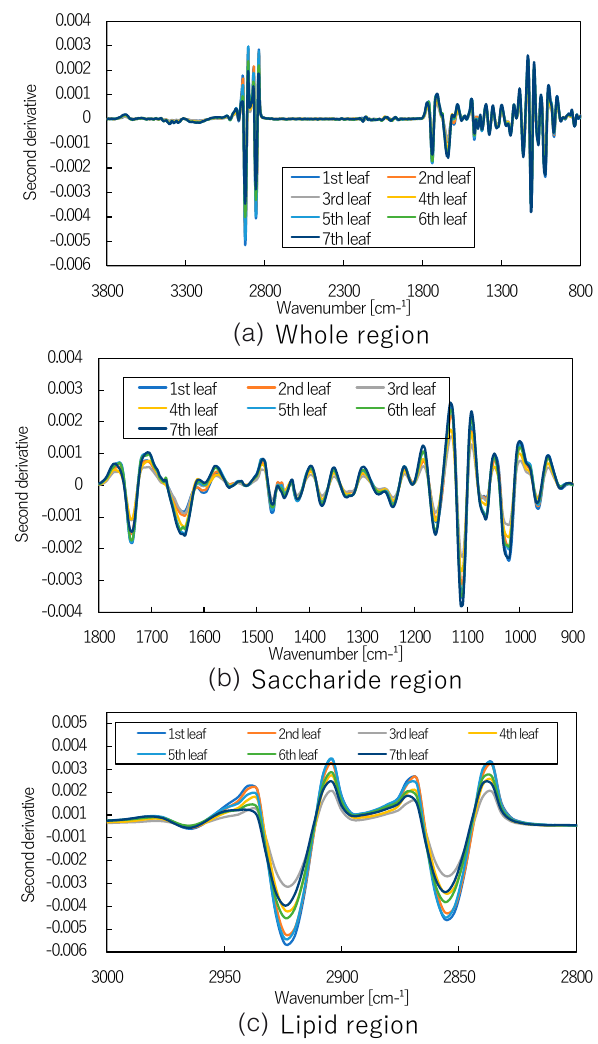
Fig. 10: FT-IR second derivative spectra of lettuce FFiigg.. 1100 FFTT--IIRR sseeccoonndd ddeerriivvaattiivvee ssppeeccttrraa ooff lleettttuuccee lleeaavveess.. 697